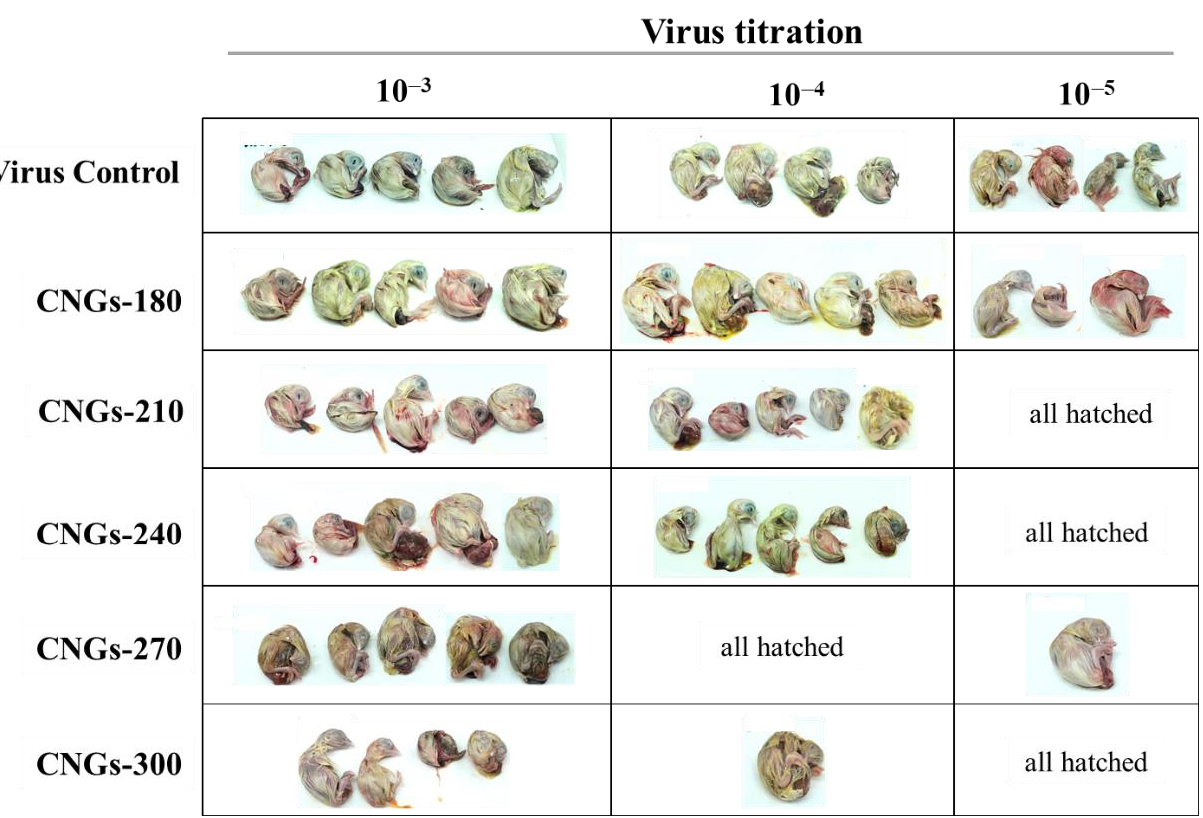
Figure 3. Image records of IBV-infected chicken embryos in the absence or presence of CNGs. IBV (10 6.25 CEID 50 mL – 1 ) was pre-incubated with CNGs (30 μ g mL – 1 ) for 30 min at room temperature and inoculated into 13-day-old chicken embryos ( n = 5). The pathological effect was recorded after 7 days of incubation. The chickens in negative controls were all hatched after 7 days of incubation and are not shown here.